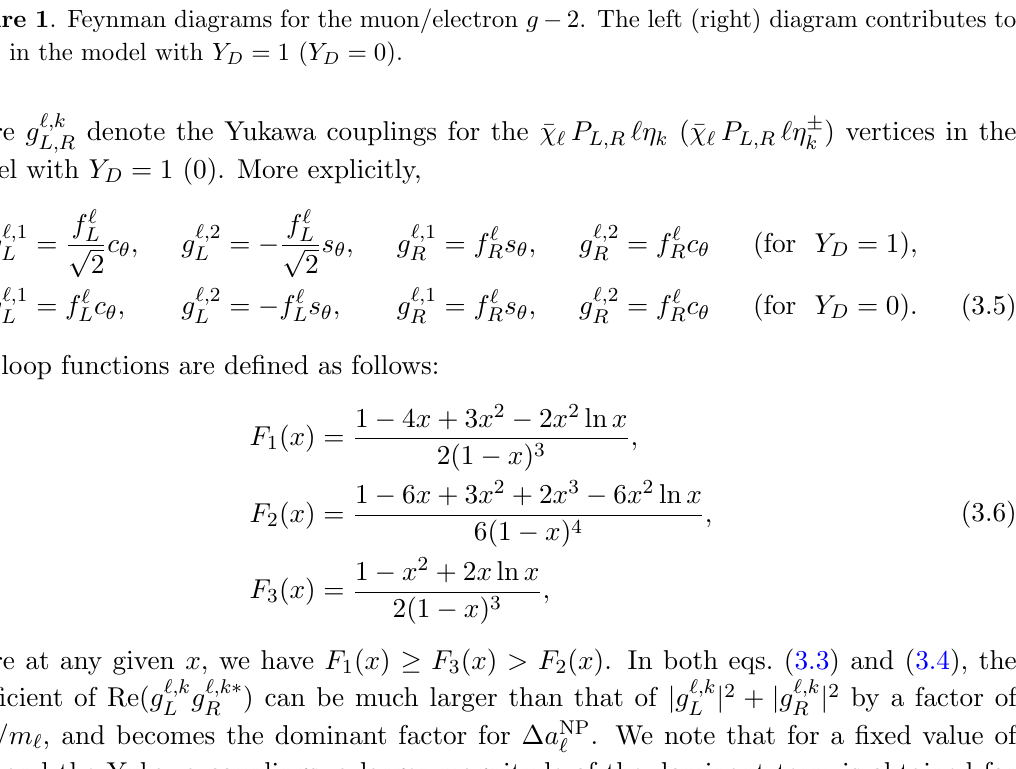
2. The left (right) diagram contributes to (cid:0)